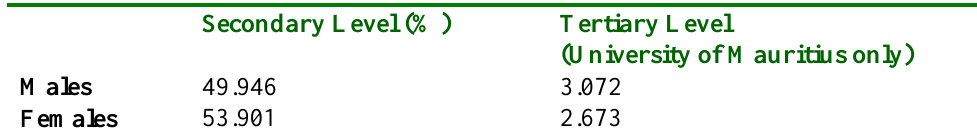
Table 1. Total Enrolment Rates by Gender and Level in Thousands for Year